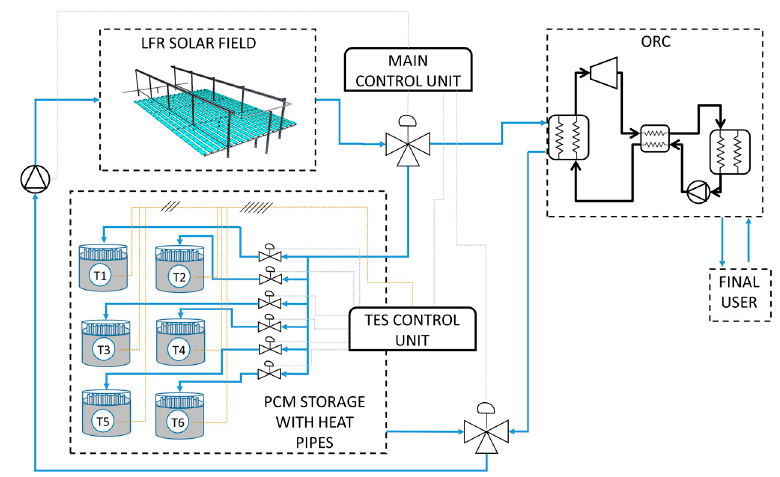
Figure 1. Schematic of the integrated system under analysis. The LHTES is shown subdivided into six sections (sub-LHTES).